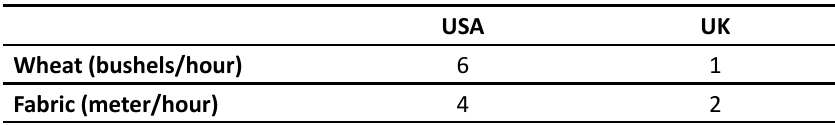
Table 1: Law of Comparative